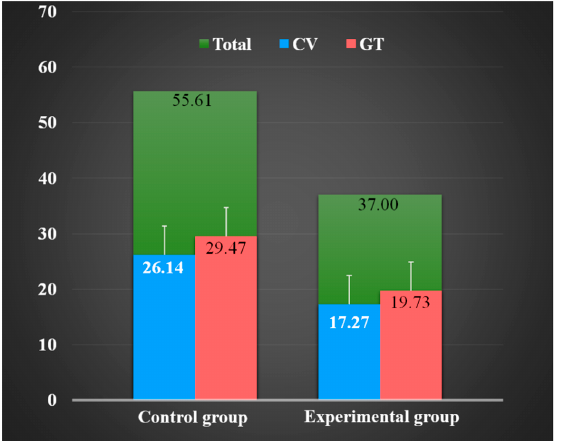
Figure 3. Decay resistance of plywood.